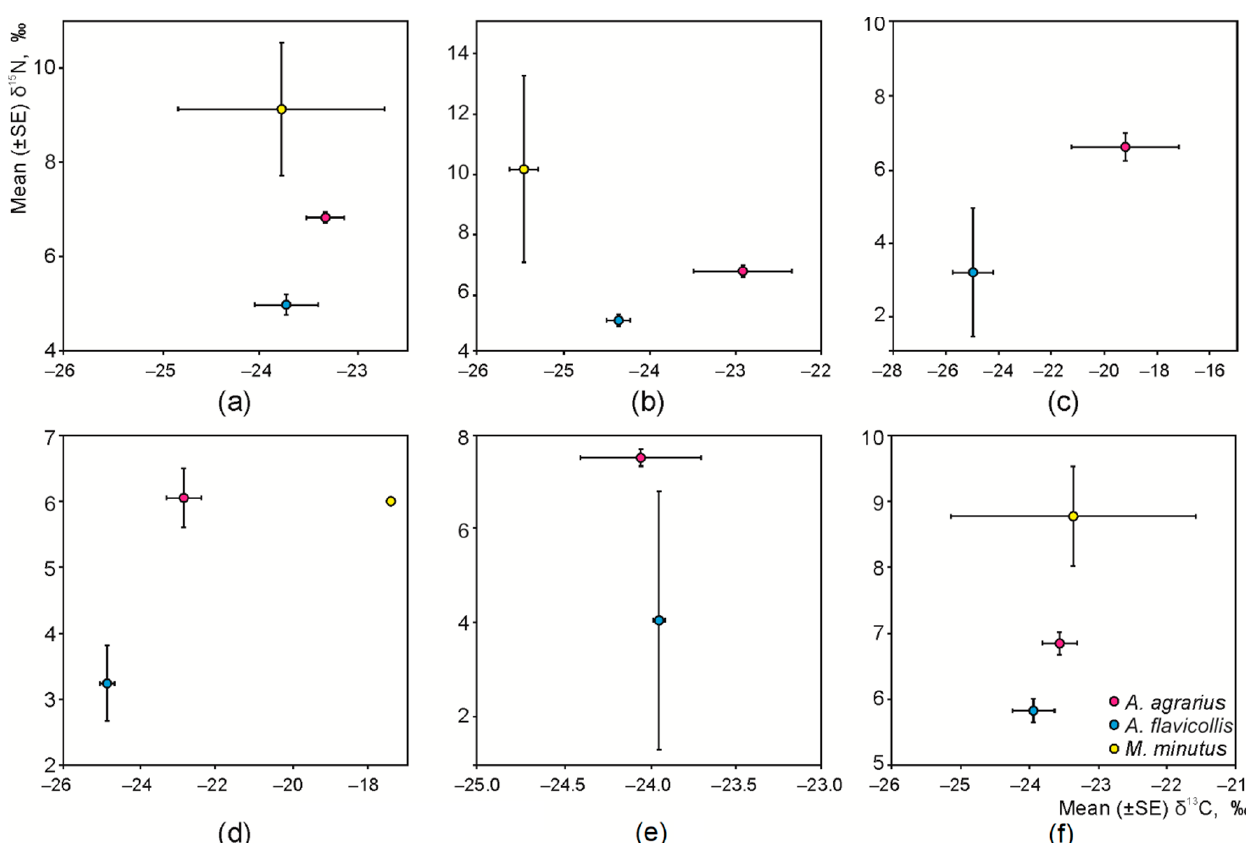
Figure 2. Distribution of syntopic granivore species according to the stable isotope ratios: ( a ) irrespective of habitat, ( b ) apple orchards, ( c ) plum orchards, ( d ) raspberry plantations, ( e ) currant plantations, and ( f ) meadows, as control habitats.